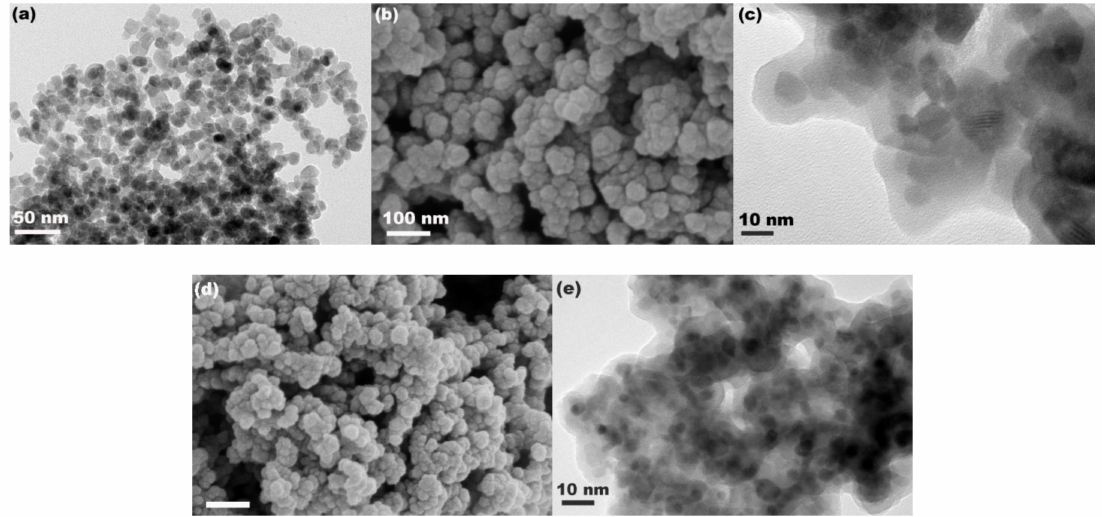
Figure 3. ( a ) TEM image of Fe 3 O 4 particles, ( b ) SEM and ( c ) TEM images of Fe 3 O 4 @SiO 2 particles, ( d ) SEM and ( e ) TEM images of Fe 3 O 4 @SiO 2 -BPMA particles.